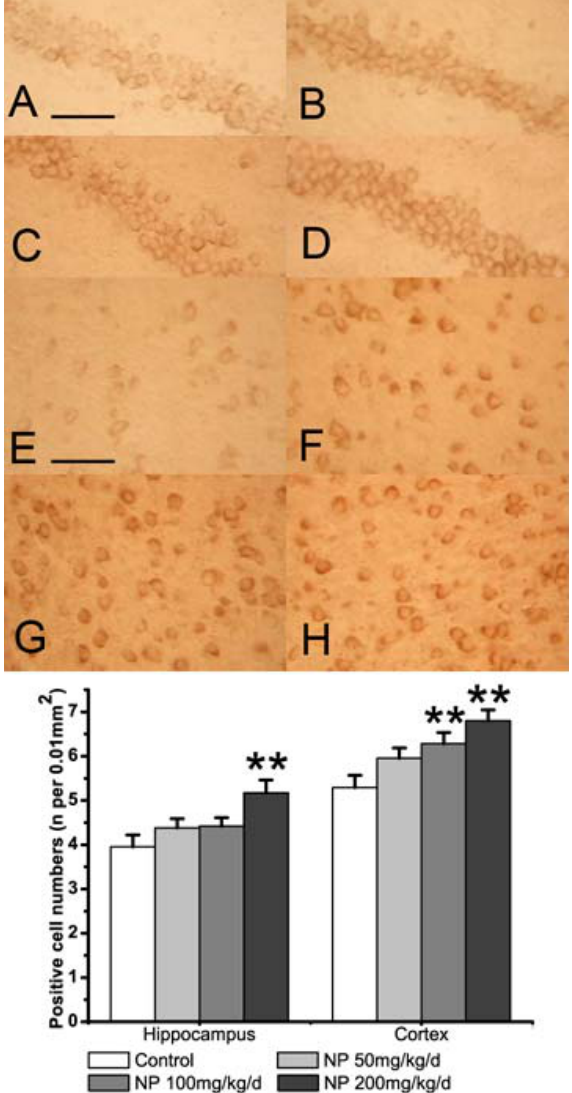
4. The effect of NP on the expression of COX-2 as determined by immunohistochemistry in the hippocampus (A-D) and cortex (E-H). (A, E) Vehicle control. (B, F) NP 50 mg/mL per day group. (C, G) NP 100 mg/mL per day group. (D, F) NP 200 mg/mL per day group. Scale bars (A–H): 100 µm. The bands below show the number of COX-2 positive cells in the hippocampus and cortex. Values are expressed